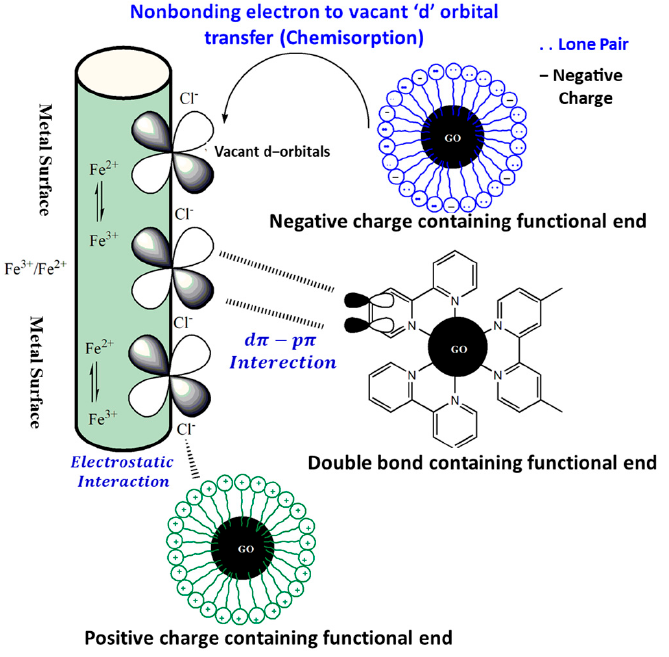
Figure 6. The interaction of metal surfaces with functionalized graphene oxide is illustrated in a series of pictures.